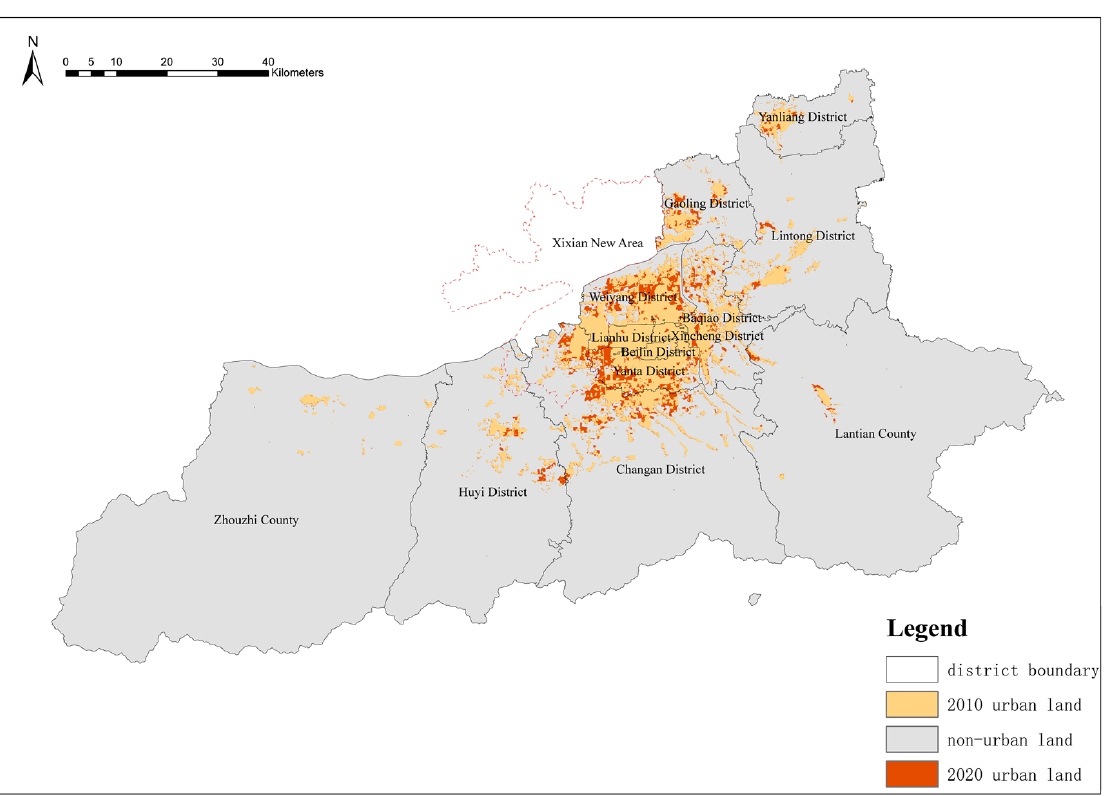
Figure 3. Urban and non-urban land of Xi’an in 2010 and 2020.